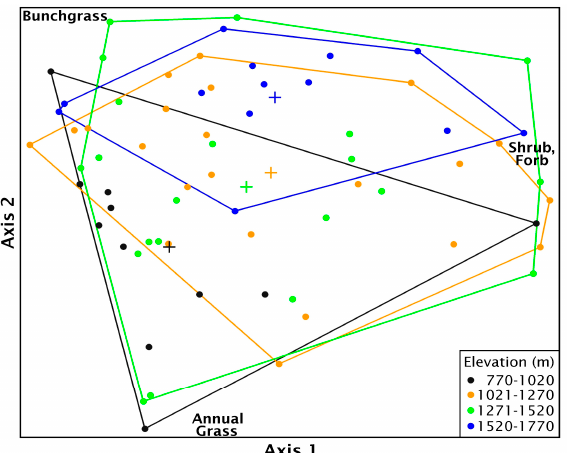
Figure 9. NMS ordination of the biomass grouped by elevation with centroids (+) for each convex hull polygon. Plant functional groups labeled in ordination space indicate where the biomass for each group was the greatest (e.g., shrub biomass increased from left to right on Axis 1 and from bottom to top on Axis 2).